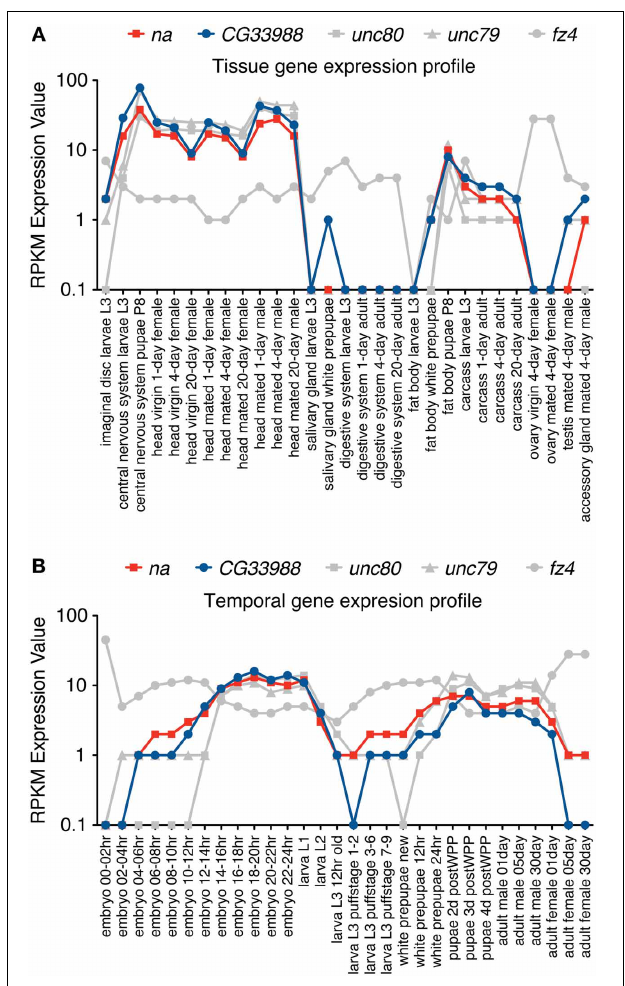
FIGURE 2 | RNA-Seq tissue and Developmental gene expression profiles for na and related genes. Shown are normalized RPKM (reads per kilobase per million mapped reads) expression values for the genes na , CG33988 , unc79 , unc80 and fz4, extracted from a collection of 29 different dissected tissues from third-instar larvae and adults (A) and 30 distinct developmental stages (B) from the modENCODE Drosophila Transcriptome project. RNA-Seq coverage data was intersected with FlyBase exons based on the gene model annotations of the current Drosophila genome release, to calculate a single value reflecting average coverage per kb per gene. Each gene data point was then classified into one of eight expression level bins, and the graphical summaries were produced from the binned values. RPKM expression values are plotted in a base 10 logarithmic scale.